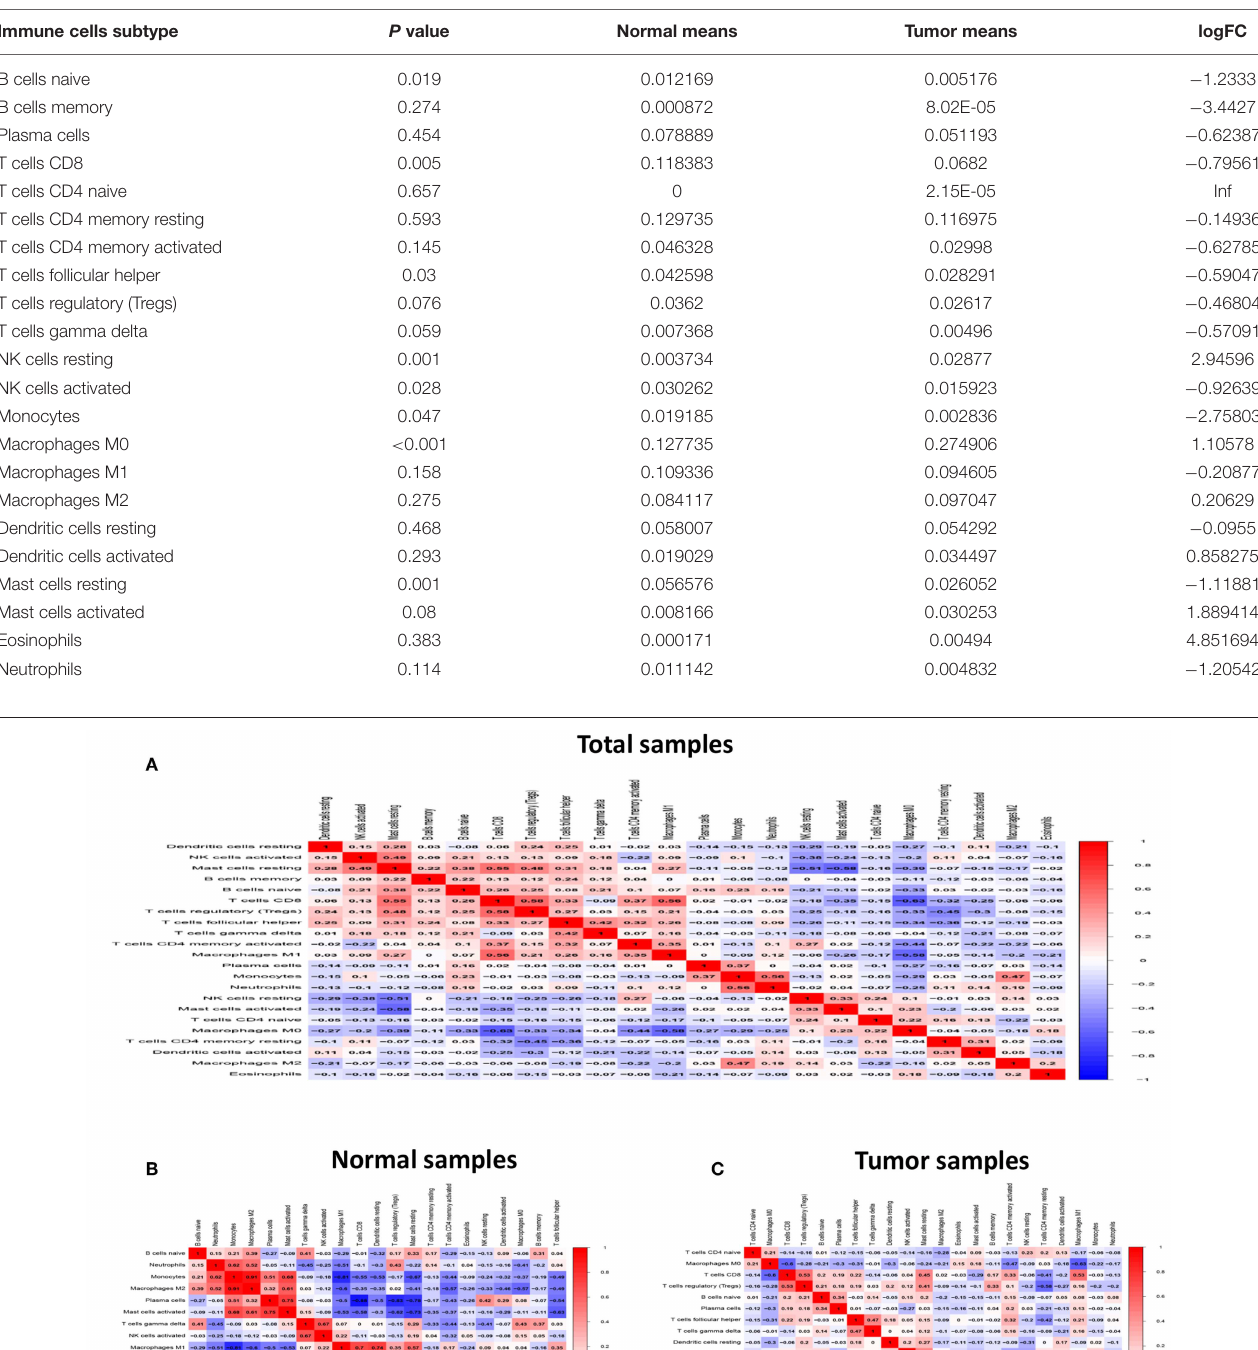
Frontiers in Oncology | www.frontiersin.org